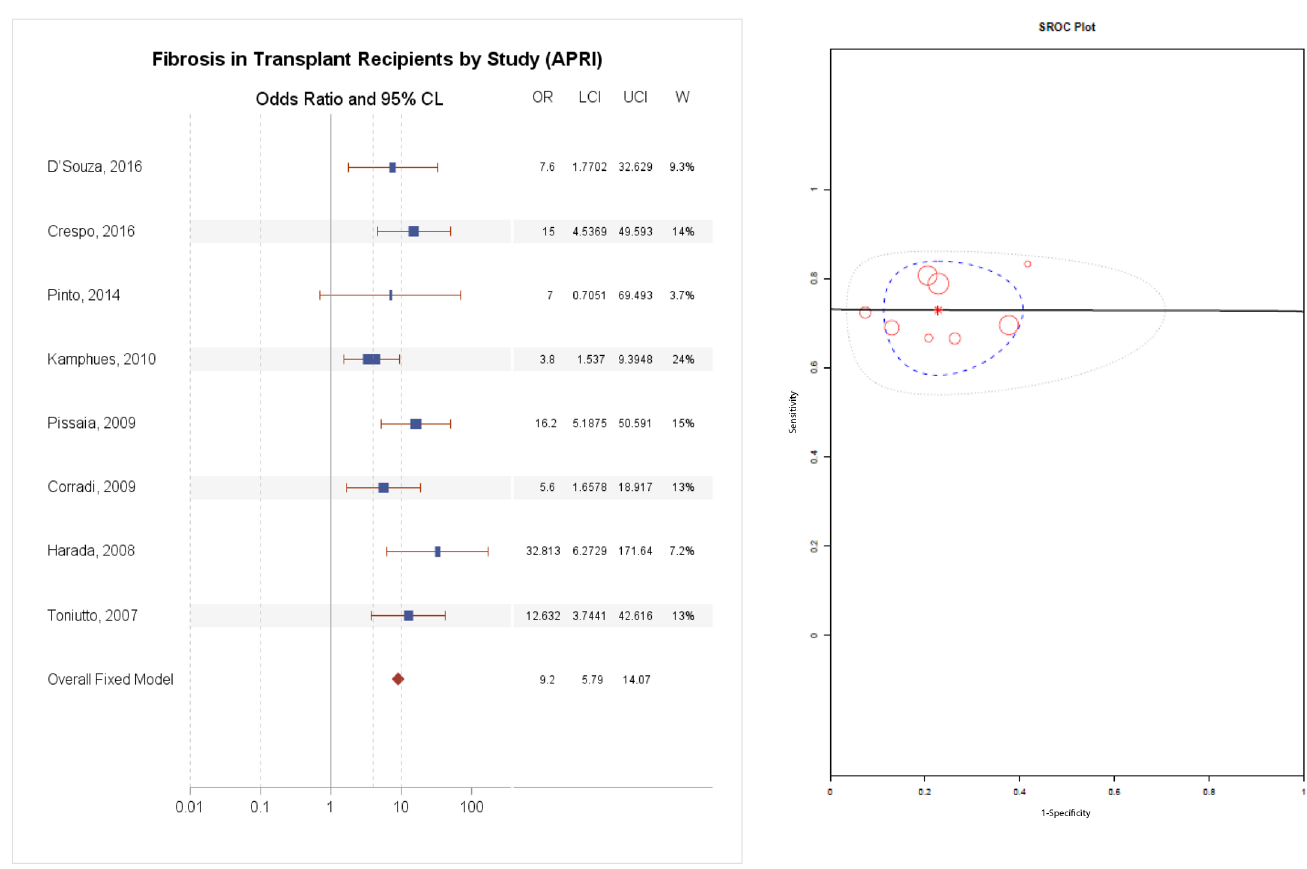
Fig 2. (A) Diagnosticaccuracyof APRI for the prediction of F2–4 fibrosis, (B) Summary ReceiverOperatingCurve.